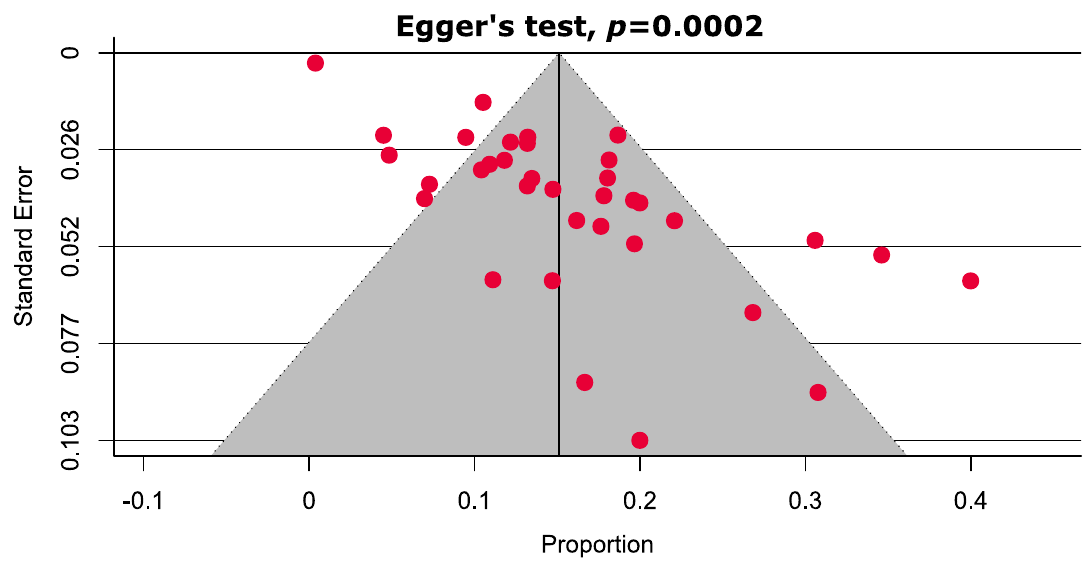
Figure 3. Funnel plot estimating the prevalence of TET2 gene mutations in patients with MPN (overall). Table 3. Sensitivity